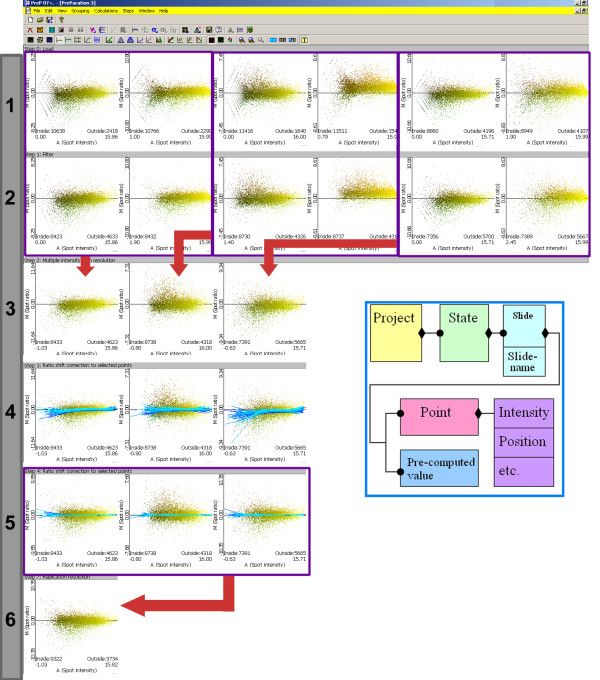
Typical steps in a complete analysis of gene expression. (by row): (1) Filtering empty spots; (2) double scan resolution; (3) Lowess estimation of parameters; (4) applying the Lowess estimation; and (5) Replicates resolution. Inside the box: object diagram of a PreP+07 project, where diamonds represent "is composed of" and circles represent "one or more" (6) final result.